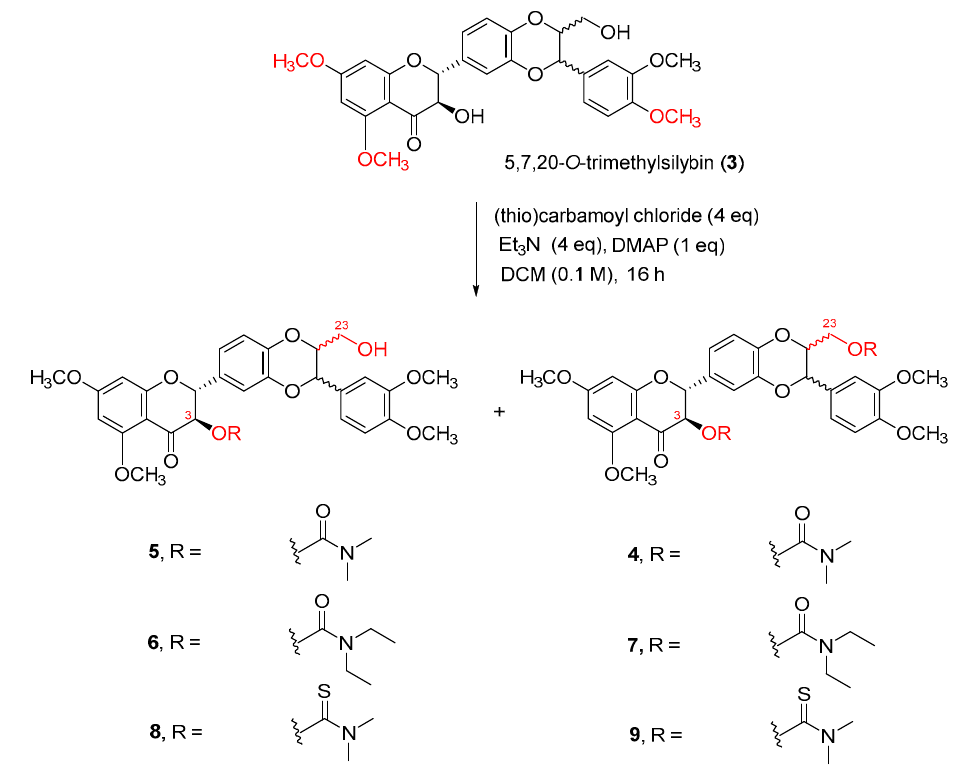
Table 1. Reaction conditions and yields for the carbamoylation of 5,7,20- O -trimethylsilybin ( 3 ). (Thio)carbamoyl Entry